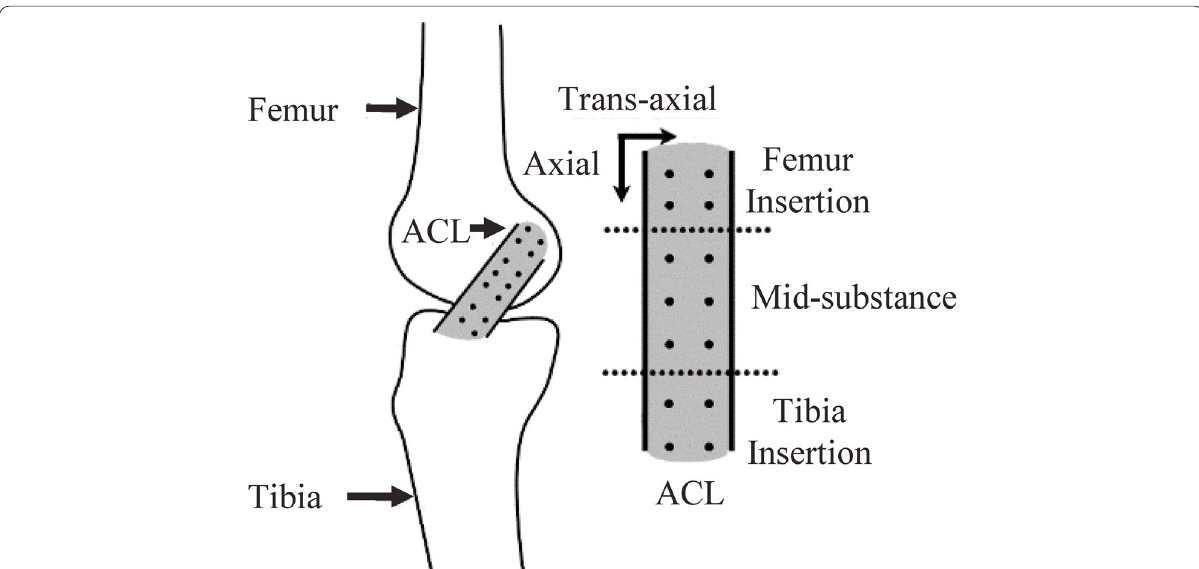
Fig. 1 Schematic representation of the knee joint and ACL showing the approximate arrangement of beads in the ACL sub-divided into the femur insertion, mid-substance, and tibia insertion